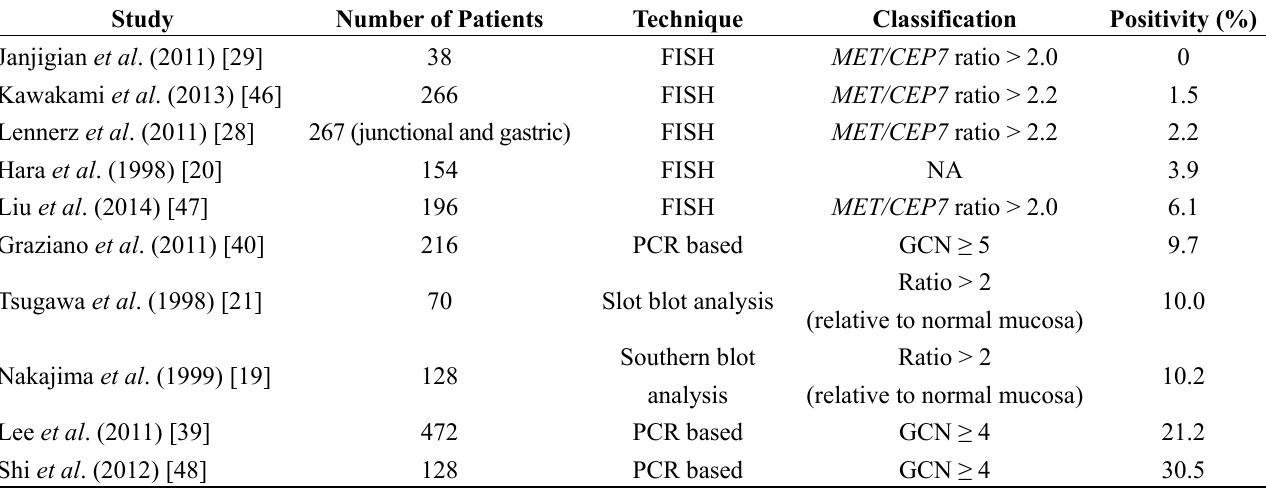
FISH, fluorescence in situ hybridization; PCR, polymerase chain reaction; GCN, gene copy number; CEP7, centromeric portion of chromosome 7; NA, not